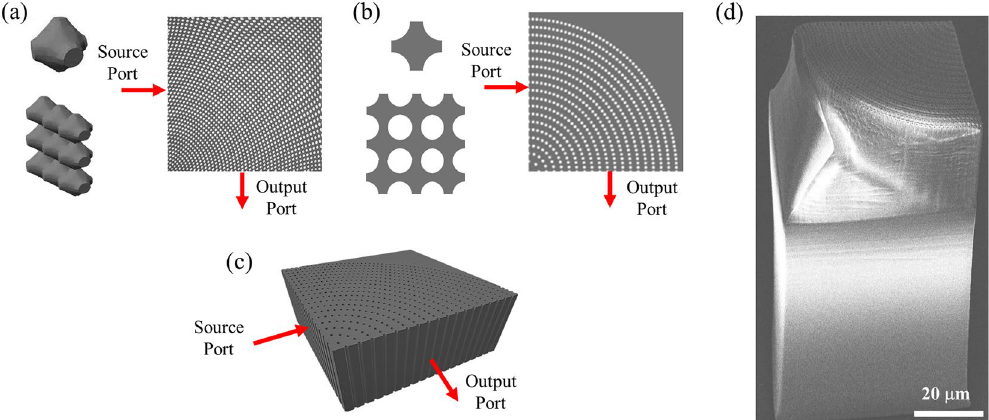
Figure 1. 2D and 3D SVPC designs. ( a ) Unit cell, standard lattice pattern, and SVPC for complex structure based on SVLs. ( b ) Simplified 2D unit cell, standard lattice pattern of unit cells, and SVPC for 90-degree bend using polar coordinate function for hole array. ( c ) 3D structures using extrusion of simplified 2D SVPC design for 90-degree bend. ( d ) SEM image of fabricated SVPC prototype atop printing pedestal. Source and output ports are identified for each